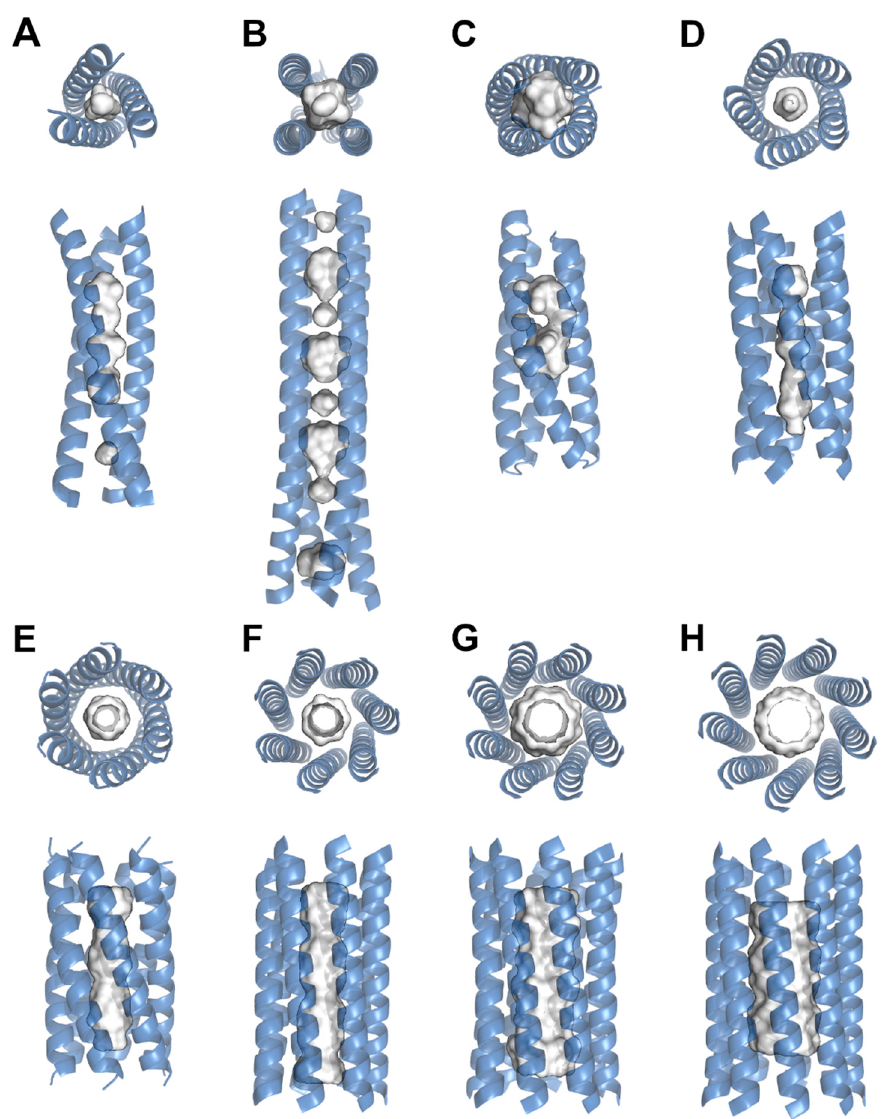
Figure 1. Structural representations of protein coiled-coil nanotubes. The protein coils and cavities for ( A ) Pb(II)C 3 (PDB: 6MCD), ( B ) RHCC (PDB: 7R6H), ( C ) ABLE (PDB: 6W70), ( D ) CC-Pent (PDB: 4PN8), ( E ) CC-Hex2 (PDB: 4PN9), ( F ) CC-Hept (PDB: 4PNA), ( G ) CC-Type2-II (PDB: 6G67), ( H ) CC- Type2-(GgLaId)4 (PDB: 7BIM) are shown. Cavity sizes and shapes are depended on the oligomeric state and internal residues. Models are based on x-ray diffraction data and were taken from the Protein Data Bank (www.rcsb.org (accessed on 3 October 2022)). Bound ligands were omitted, and